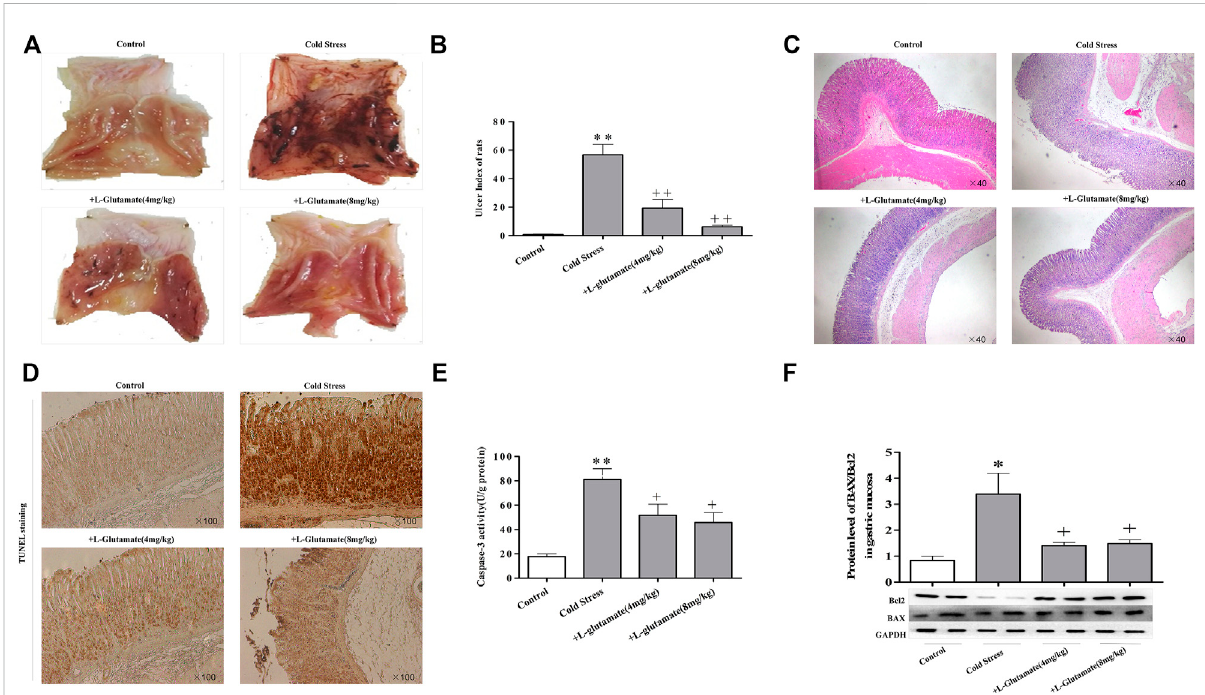
FIGURE 2 Exogenous glutamate supplementation attenuates gastric mucosa injury induced by cold stress. (A) Gastric mucosal injury in rats. (B) Gastric mucosal ulcer index of rats. (C) Morphological changes of rat gastric tissue by light microscopy (×40). (D) Apoptosis observed in sections (×100). (E) Caspase-3 activity. (F) Expression of BAX/Bcl-2. Data are expressed as mean ± standard error ( n = 8). * p < 0.05, ** p < 0.01 vs. Control, + p < 0.05, ++ p < 0.01 vs. Cold stress. Glu: